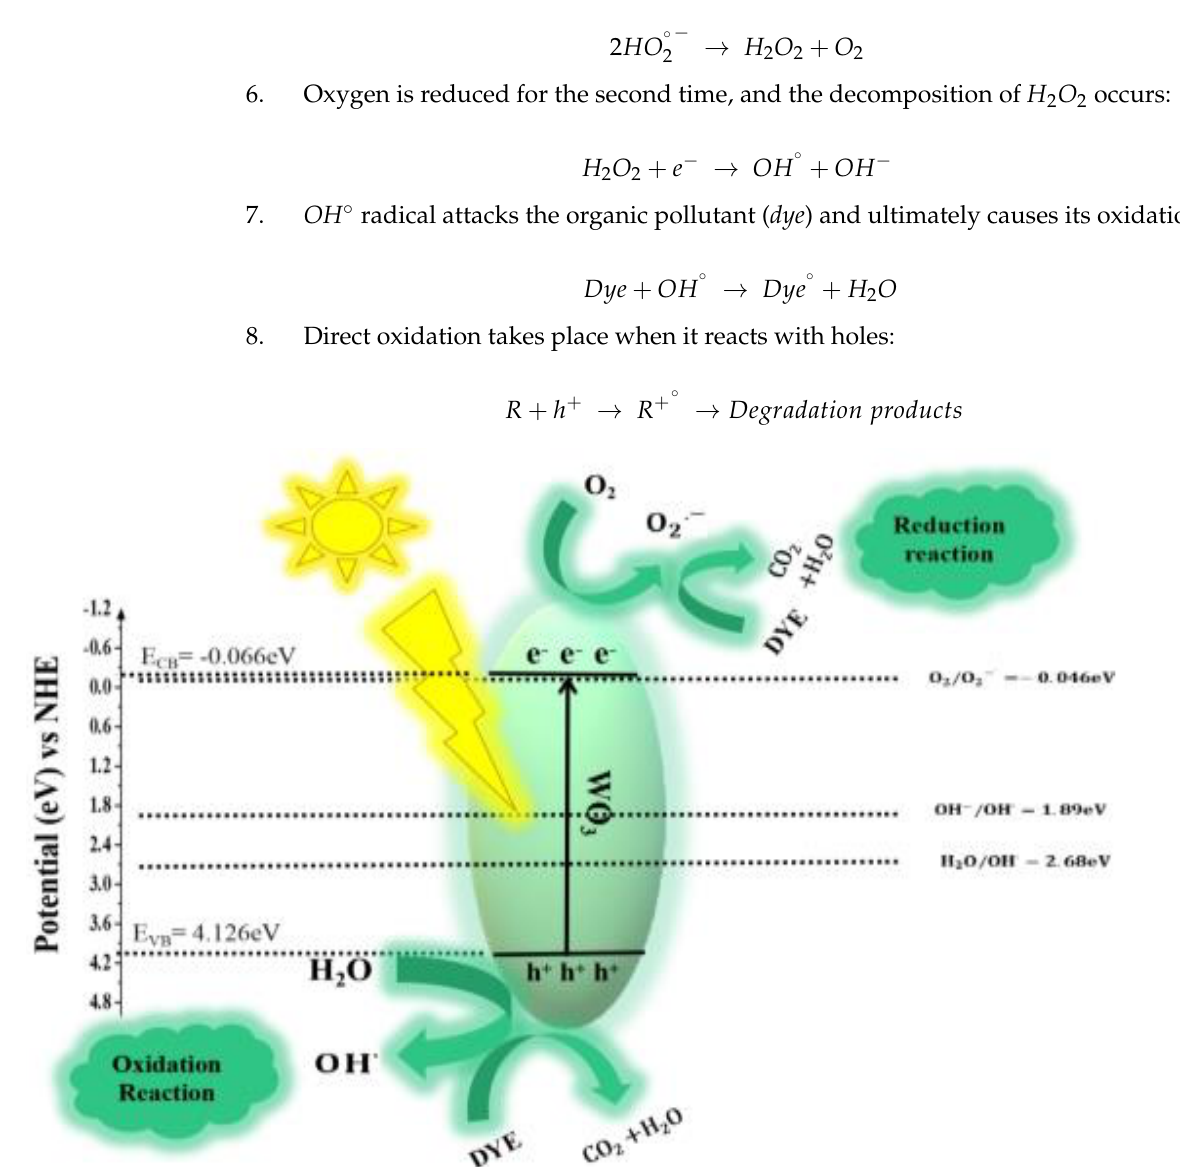
Figure 12. Z-scheme mechanism for the photocatalytic activity of WO 3 .